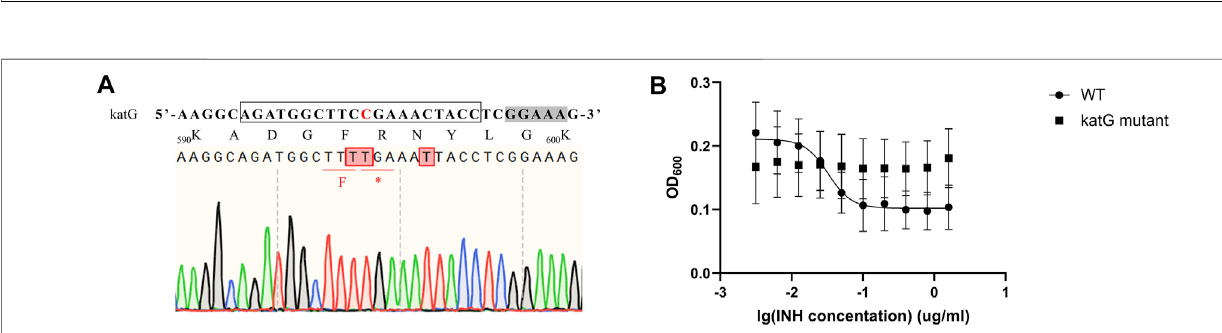
Frontiers in Genome Editing |